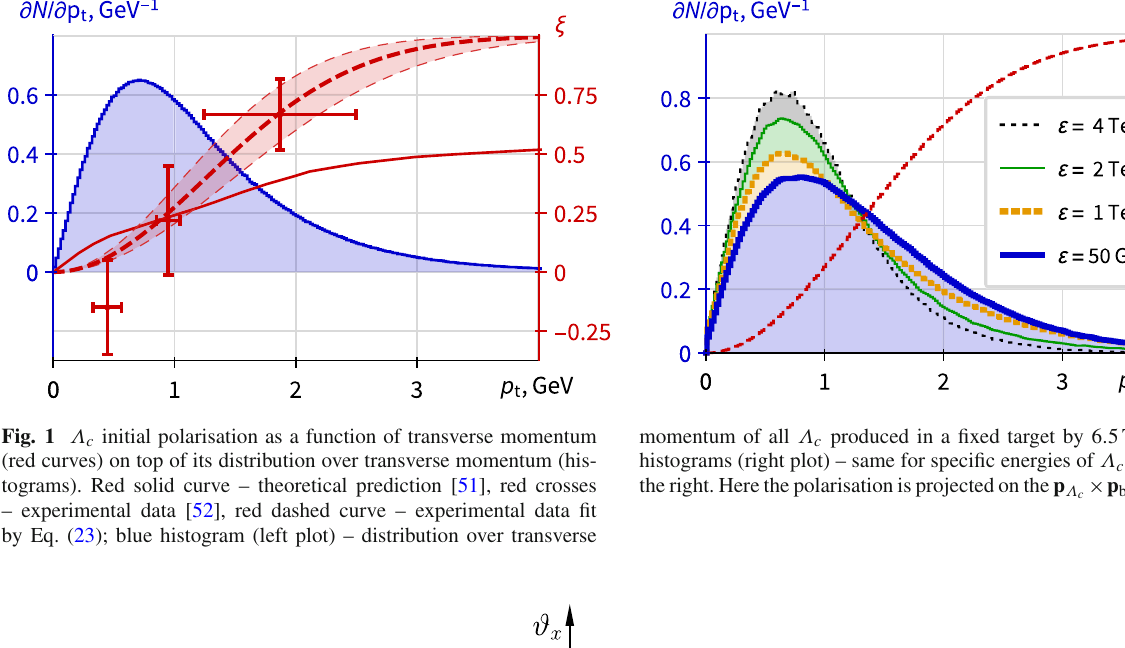
× p beam direction c